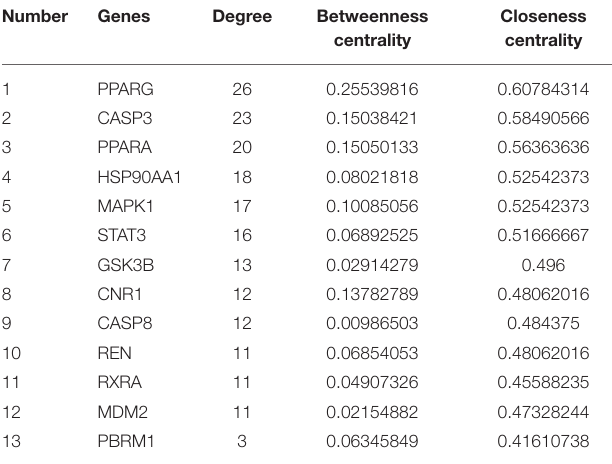
TABLE 3 | Topological parameters of hub genes in the PPI